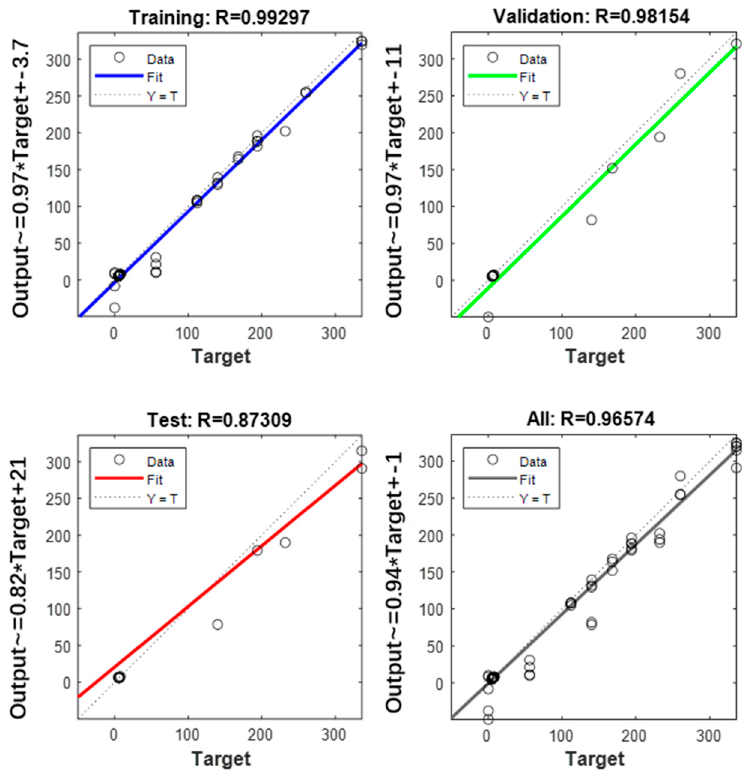
Figure 7. BP-ANN model fitting results for total acid content and storage days of Sichuan Sauerkraut based on NIR.